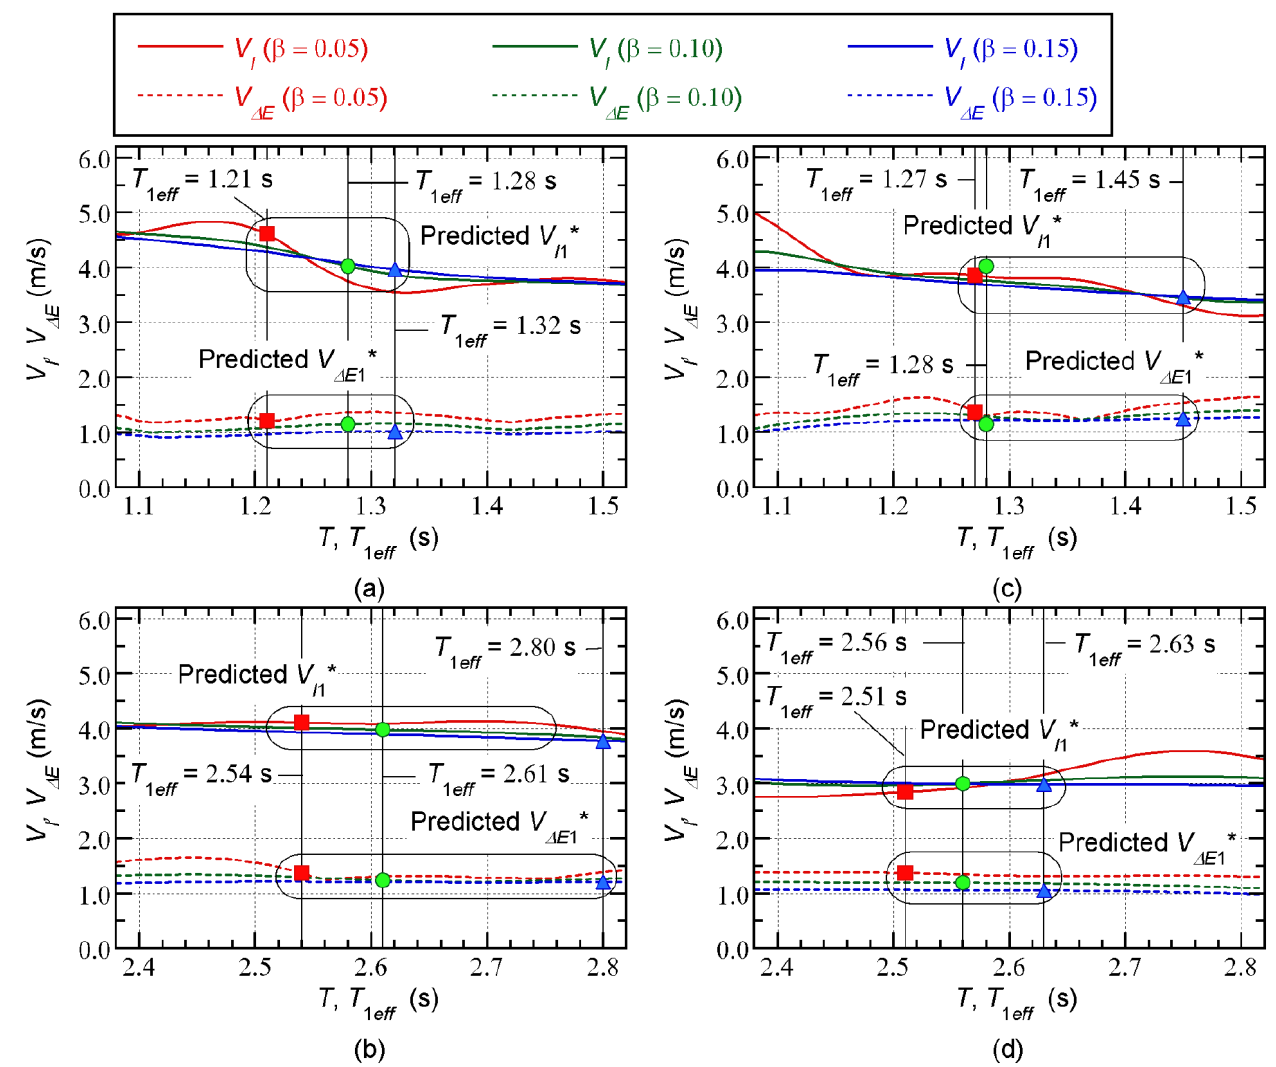
Figure 9. Prediction of the equivalent velocity of the cumulative input energy for the first modal response ( h 1 f = 0.05): ( a ) 8-story model (Art-L series); ( b ) 16-story model (Art-L series); ( c ) 8-story model (Art-S series); ( d ) 16-story model (Art-S series).